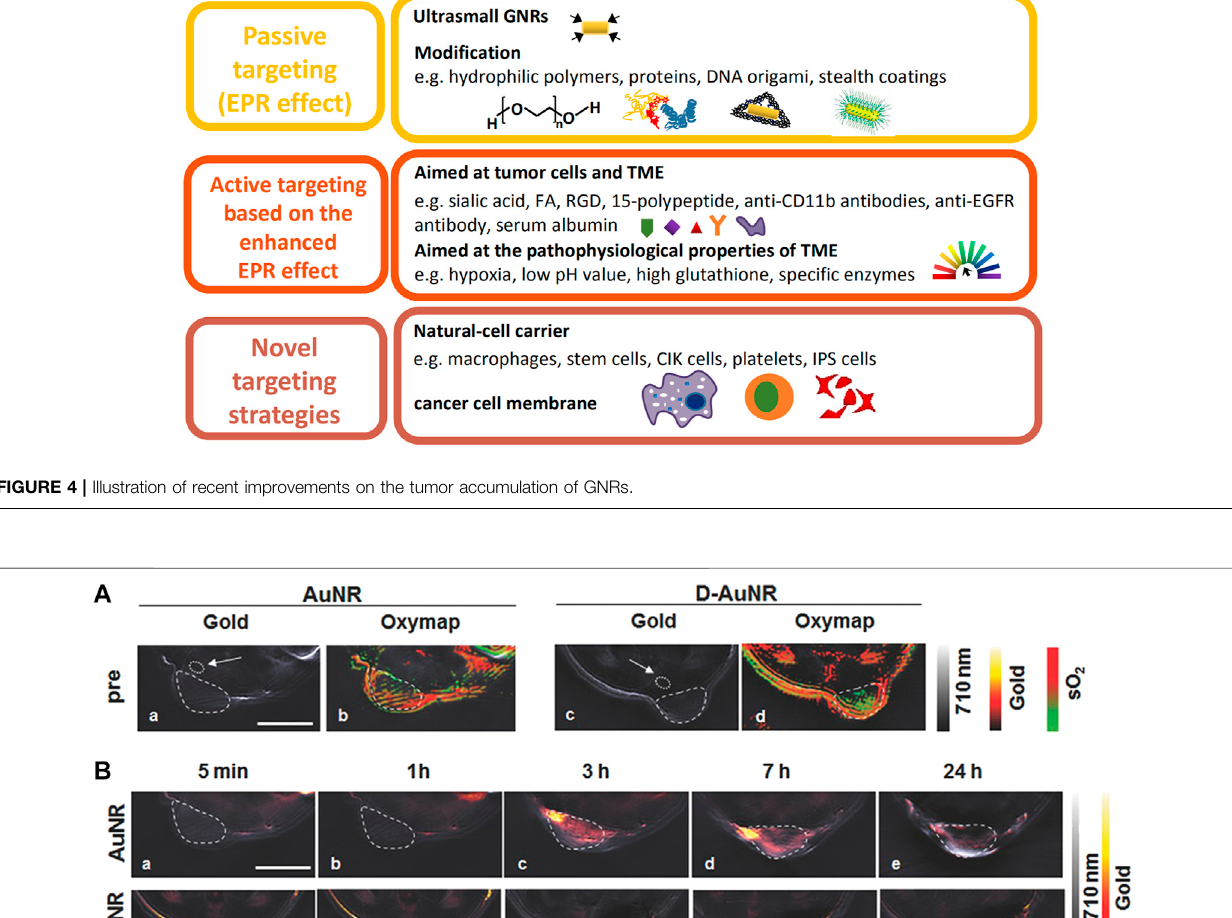
Frontiers in Pharmacology |